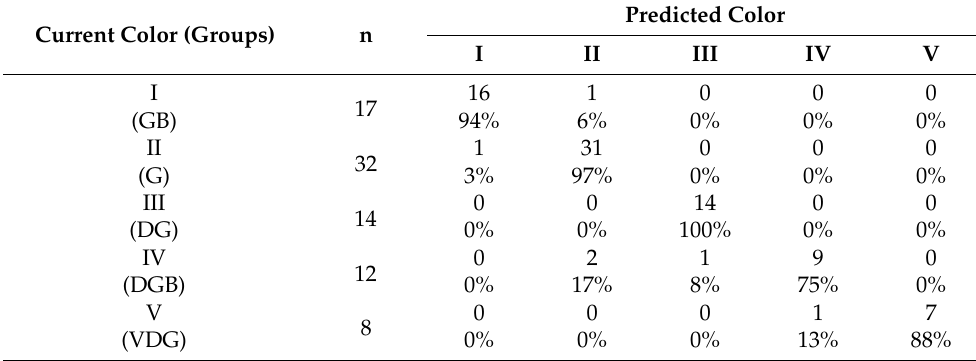
Table 1. Congruence matrix between the color groups of road dust based on the Munsell color cards (discriminant variable) and those groups formed based on the color indices (classification variables). Predicted Color Current Color (Groups) n I